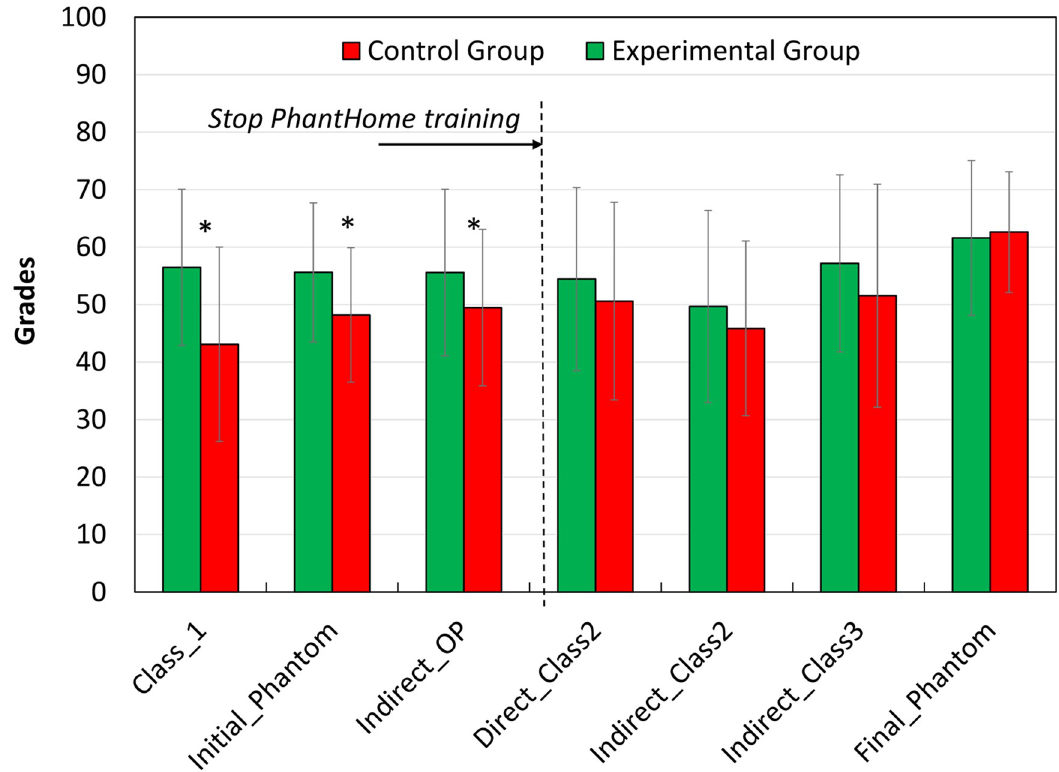
Fig 5. Mean clinical grades of phantom exams of the experimental (N = 41) and control (N = 59) groups during the phantom course. � Significant differences between mean values of the groups for the specific exam (p < 0.05).